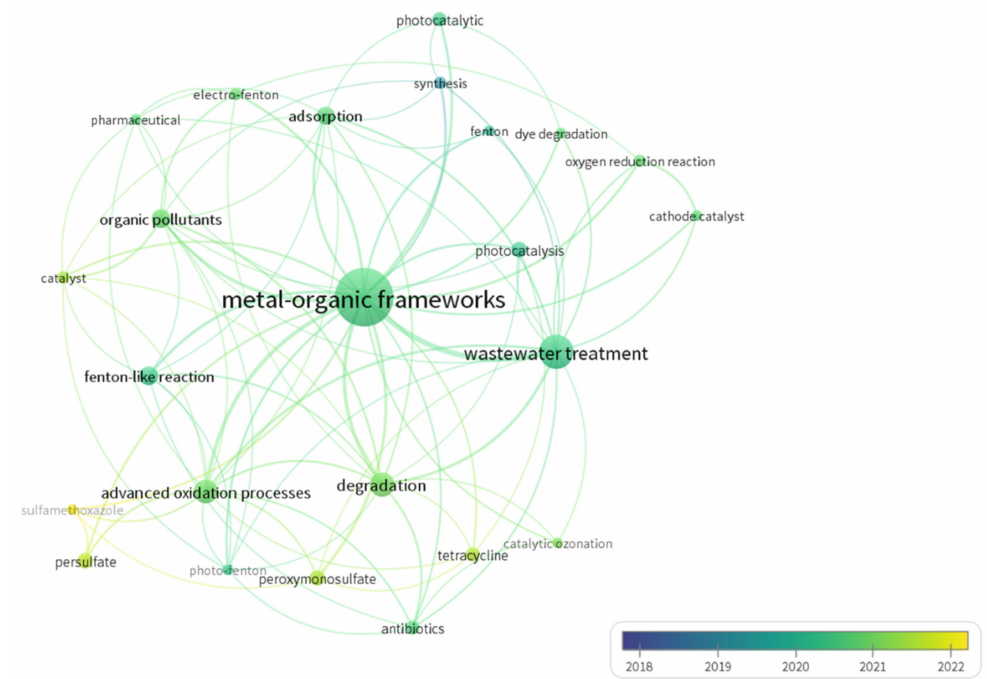
Figure 7. Keywords and overlay visualization co-occurrence analysis of AOPs using MOFs in wastewater research using VOS